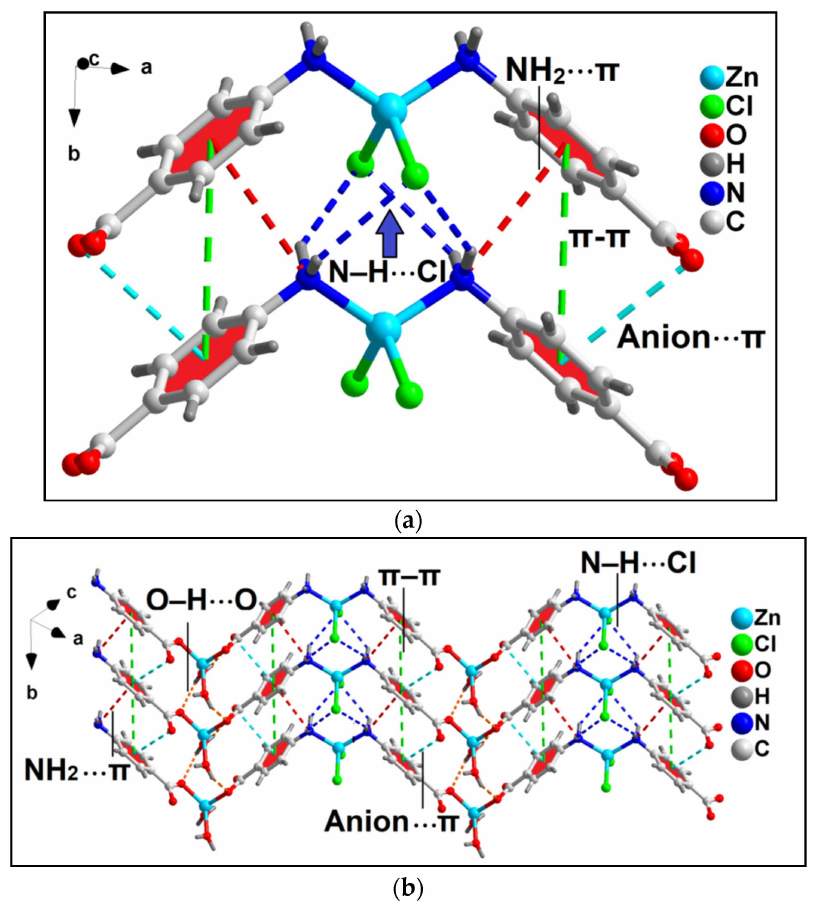
Figure 3. ( a ) Model dimeric assembly in the crystal structure of the polymer 1 involving anion · · · π , NH 2 ( amino ) · · · π , π – π , and N–H · · · Cl interactions; ( b ) 2D network architecture of compound 1 along the crystallographic ab